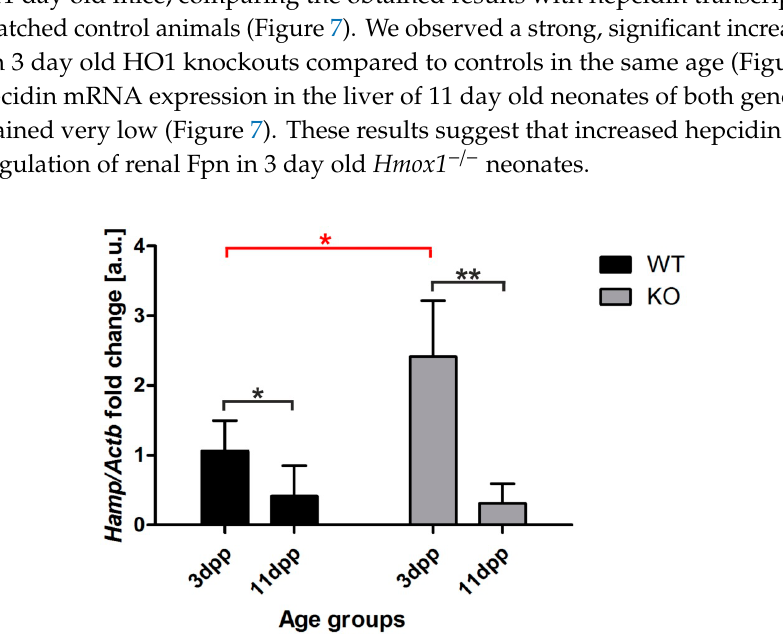
Figure 7. Hepcidin ( Hamp) expression in the liver of wild-type (WT) and heme oxygenase 1 (HO1) knockout (KO) mice. RT-qPCR analysis of hepcidin mRNA levels in the livers of WT and KO 3 and 11 day old mouse neonates. The graph presents relative hepcidin transcript levels in arbitrary units (means ± SD, n = 5 per group). To compare differences, we used Student t- test; * p < 0.05, ** p < 0.01. dpp—days postpartum.